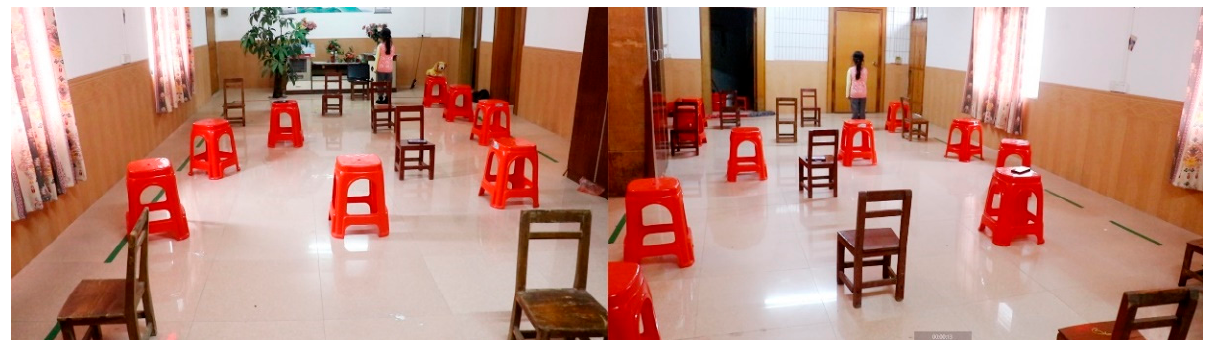
Figure 5. AR orientation aid equipment study site.